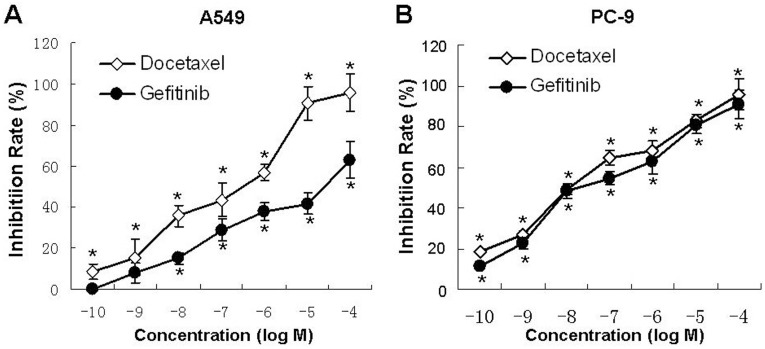
Docetaxel or gefitinib alone inhibited the proliferation of lung adenocarcinoma cells in a dose-dependent manner.Cells were treated with gradient concentrations (10−4 M∼10−10 M) of gefitinib or docetaxel for 72 h. Cell proliferation was determined by MTT assay. (A) A549 cells; (B) PC-9 cells. *P<0.05 compared with control group. Bars: ± SD, n = 3.